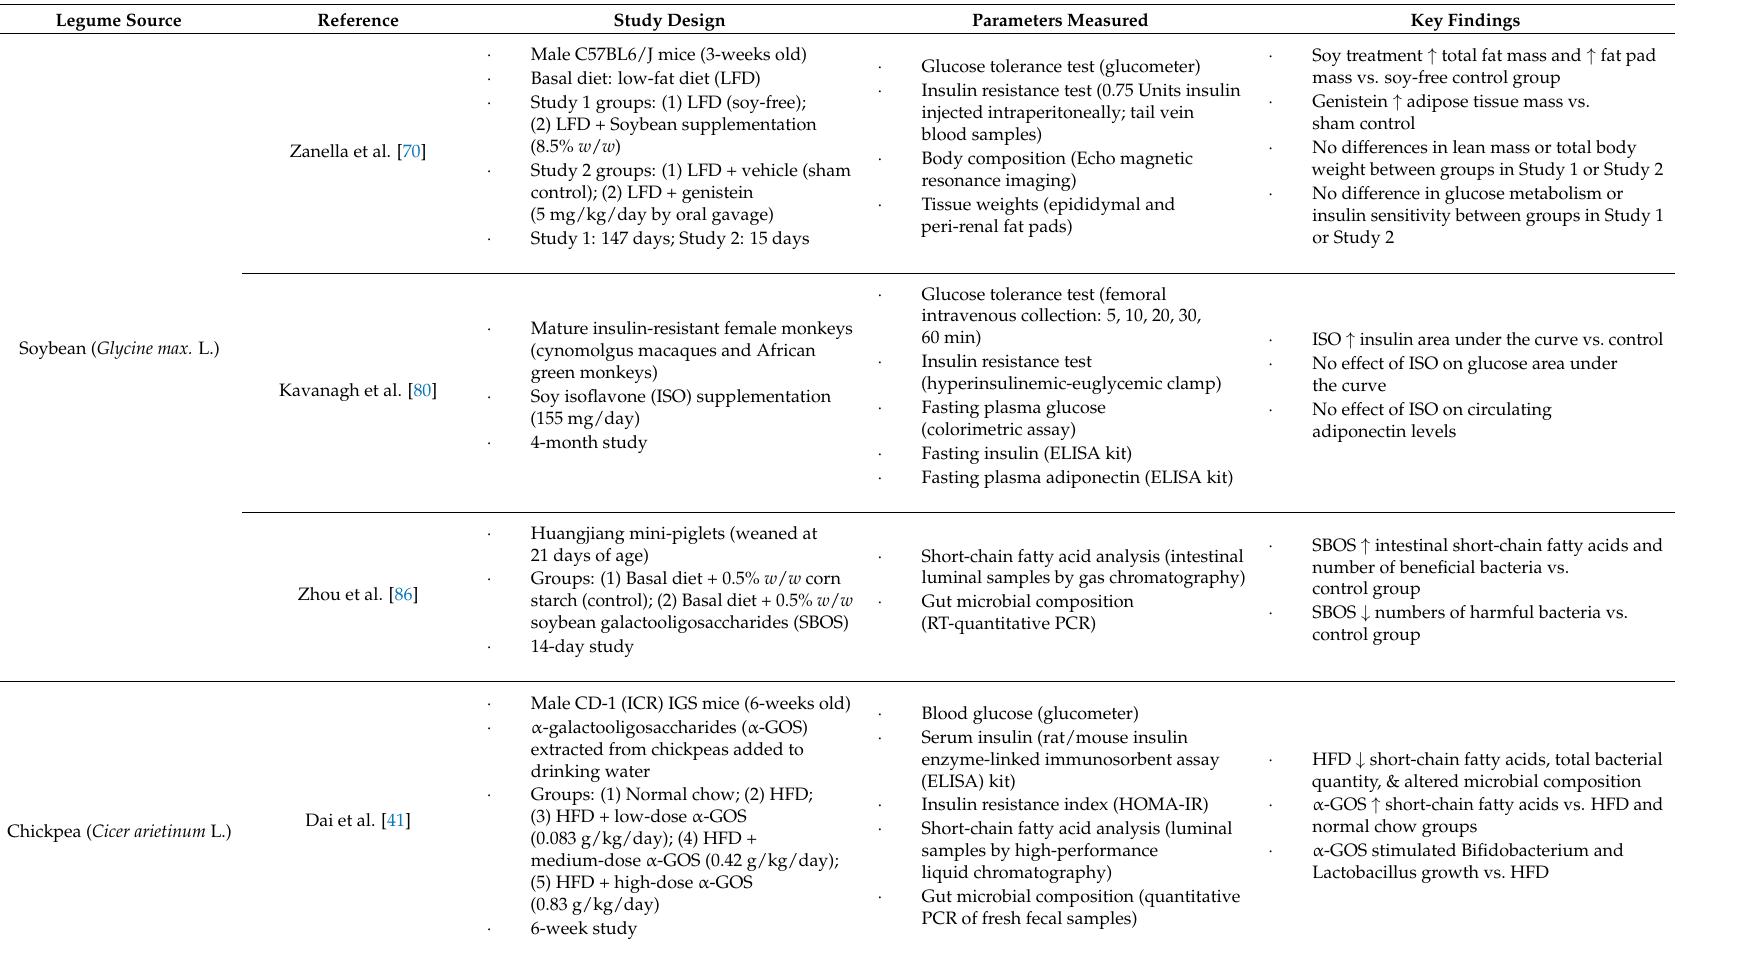
Legume Source Parameters Measured Key